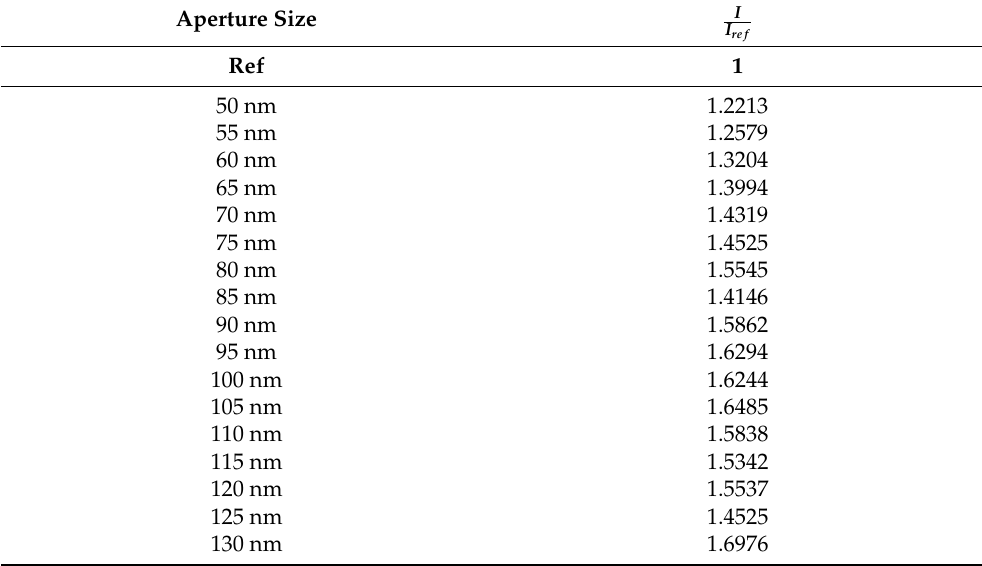
Table 3. Periodicity sweep at 5 µm with terminal current